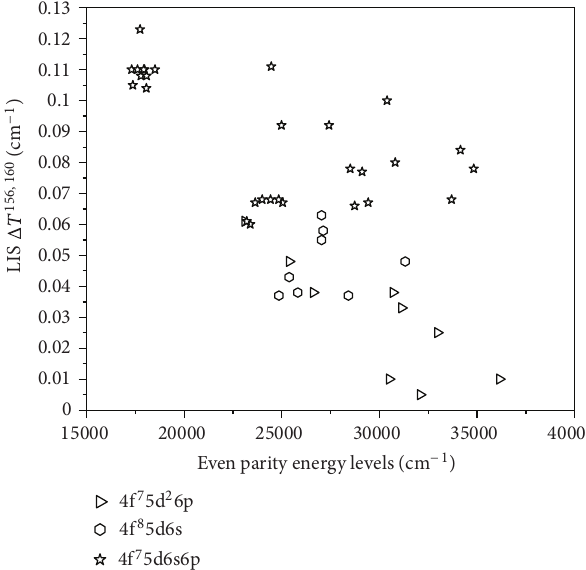
Figure 2: Even-parity energy levels (cm −1 ) plotted against their respective experimental LIS Δ𝑇 156,160 (cm −1 ) values. As seen in the Figure levels belonging to 4f 7 5d6s6p and 4f 7 5d 2 6p configurations in the range of 22500–30000 cm −1 have been mixed together suggesting configuration interaction whereas the cluster of extreme low even-levels of pure 4f 7 5d6s6p and extreme high even-levels of pure 4f 7 5d 2 6p configurations is free from configuration